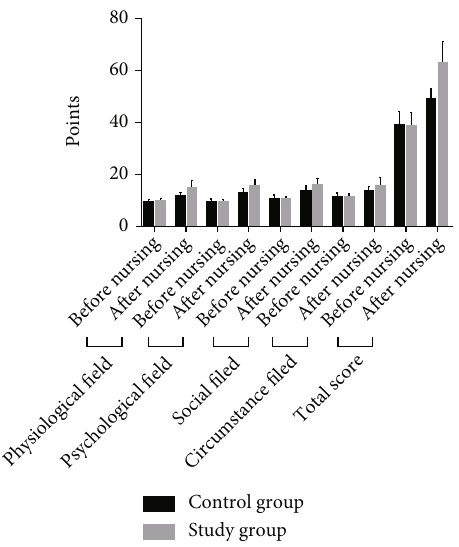
Figure 6: Histogram comparing the quality of survival scores before and after patient care for the two groups. Table 9: Comparison of prognosis between the two groups (n, %).